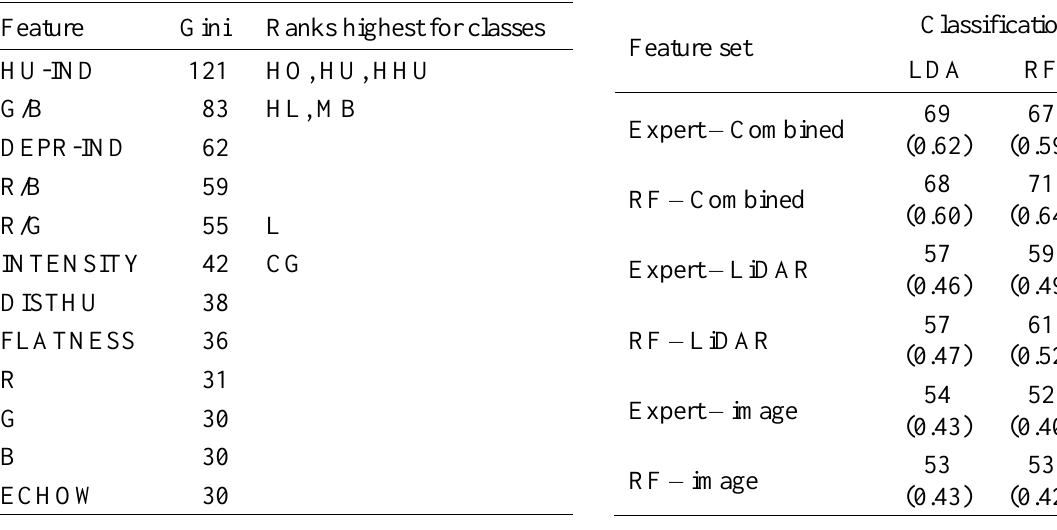
Table 8. Twelve variables selected by RF (sensors